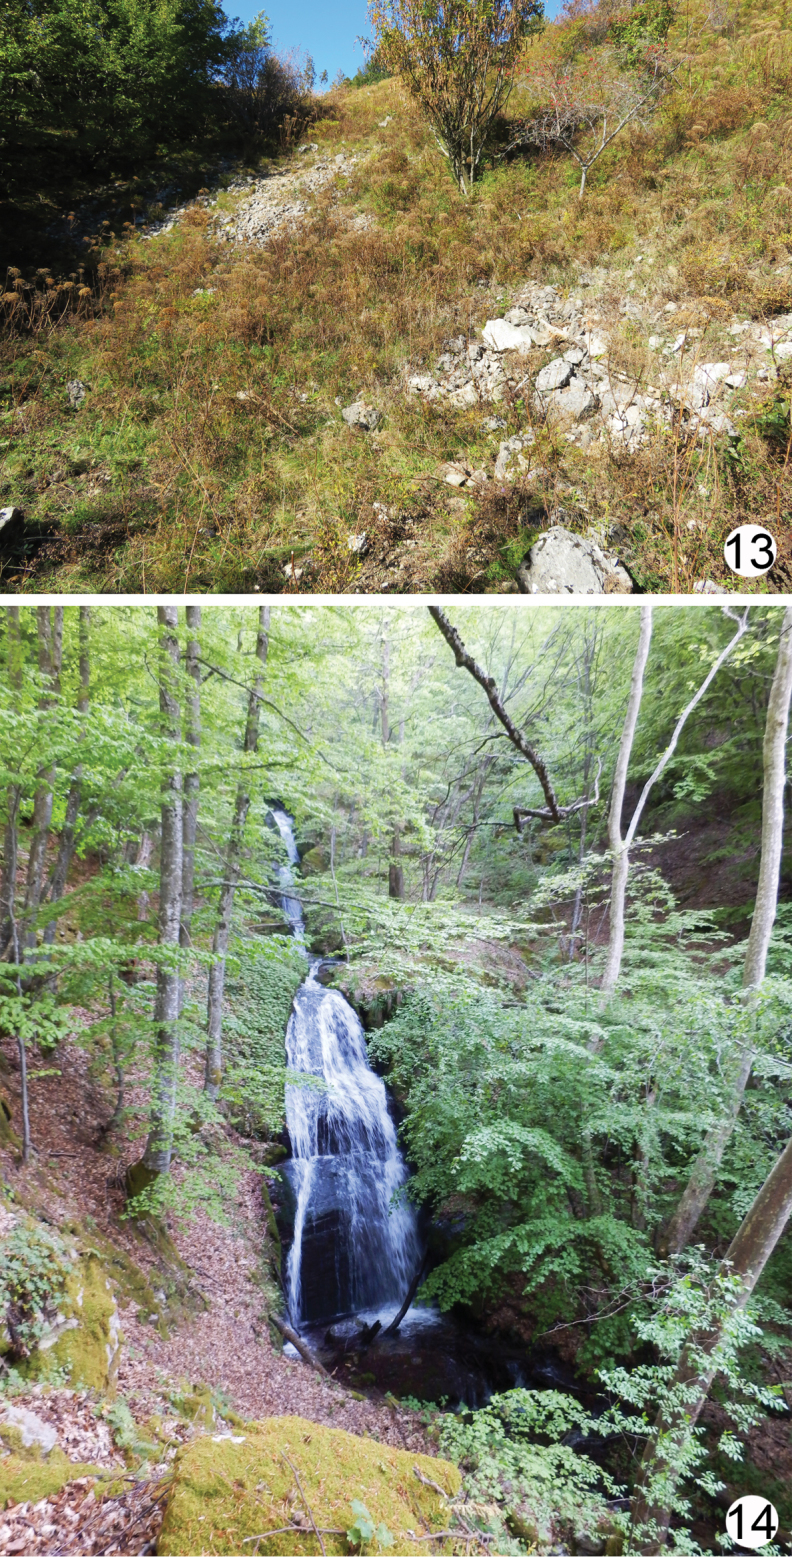
Habitat of A.illyrica13 locality Velika Milanja, Slovenia 14 locality Kamena, Bulgaria.